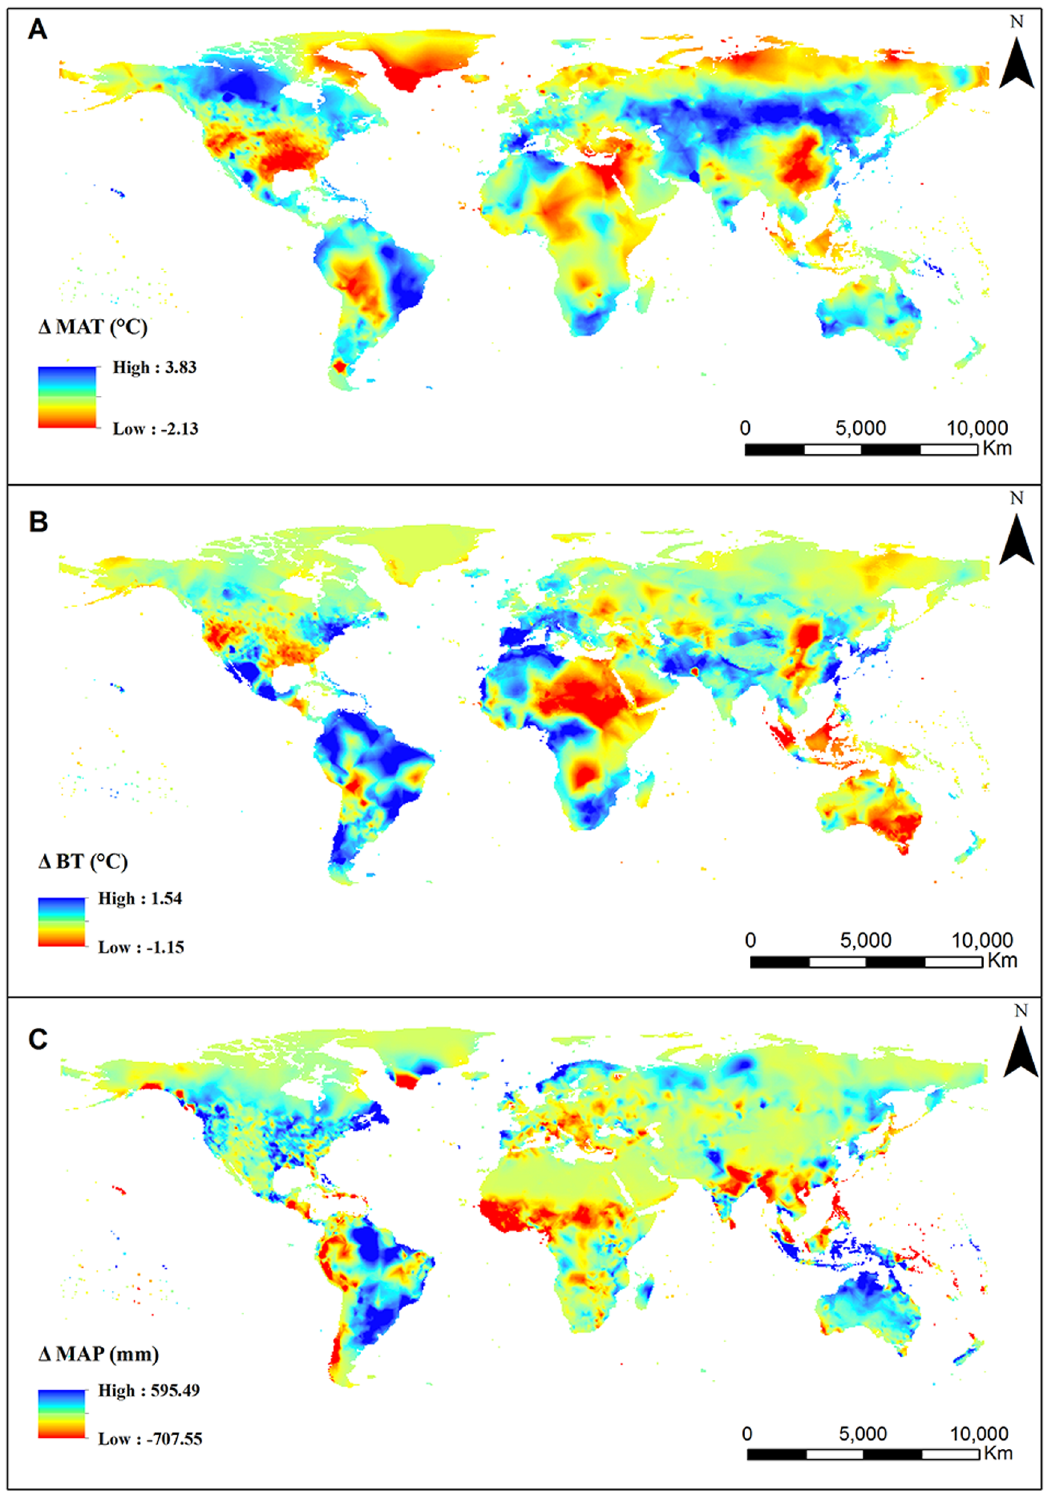
Figure 1. Dynamic of climate factors in the period 1911–2000. The variations of climatic variables were derived from CRU_TS 2.1 data. (a): mean annual temperature (MAT), (b): biological temperature (BT), (c): mean annual precipitation (MAP).